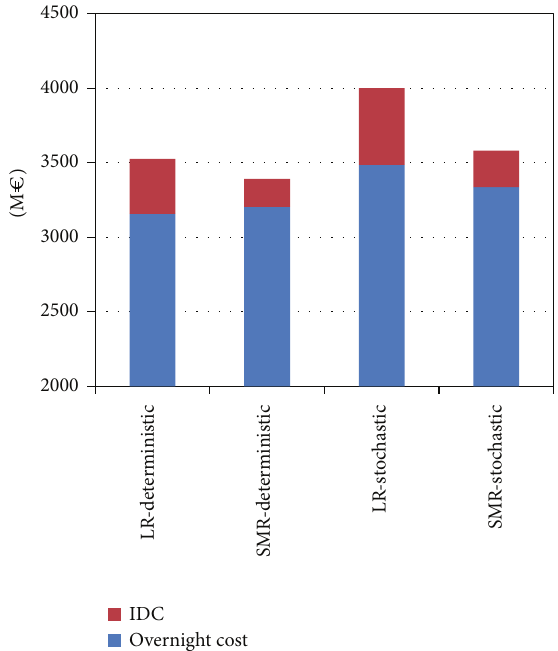
Figure 11: Total Capital Investment Cost (overnight cost + IDC) of SMR and LR under deterministic and stochastic scenario con-